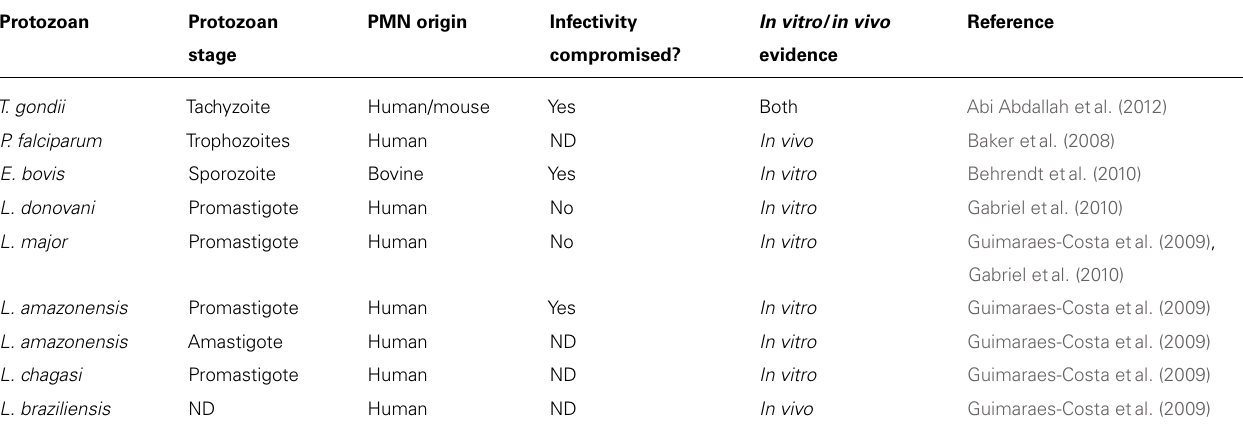
Table 1 | NET induction by